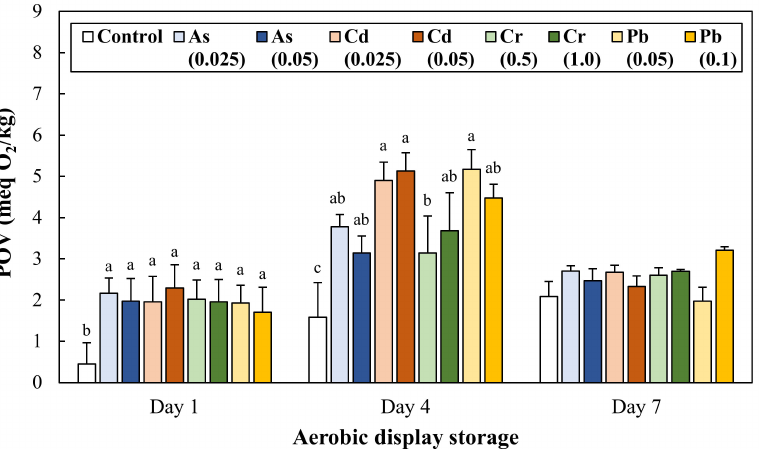
Figure 2. Change in peroxide value (POV) of ground pork intentionally contaminated with toxic heavy metals during 7 days of aerobic display storage. The number in parentheses in legend indicates the target concentration (mg/kg) of each heavy metal in ground pork. Error bars represent each standard error (S.E.). The letters a–c represent results that are not significantly different from each other within each display storage ( p ≥ 0.05).